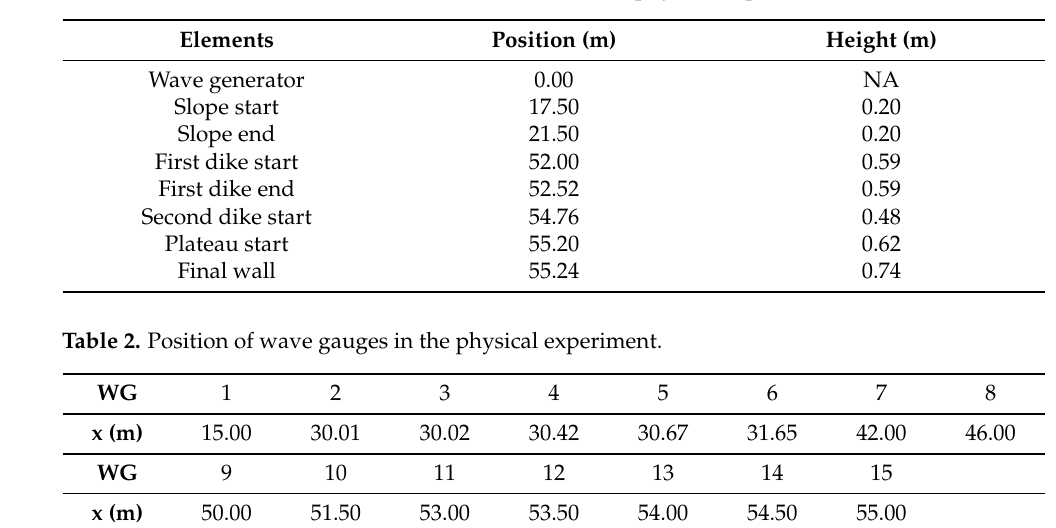
Figure 3. Configuration of the physical wave tank in the experiment [33], with the focus on the double-dike defence structure. Table 1. Position of different elements of structures in the physical experiment.